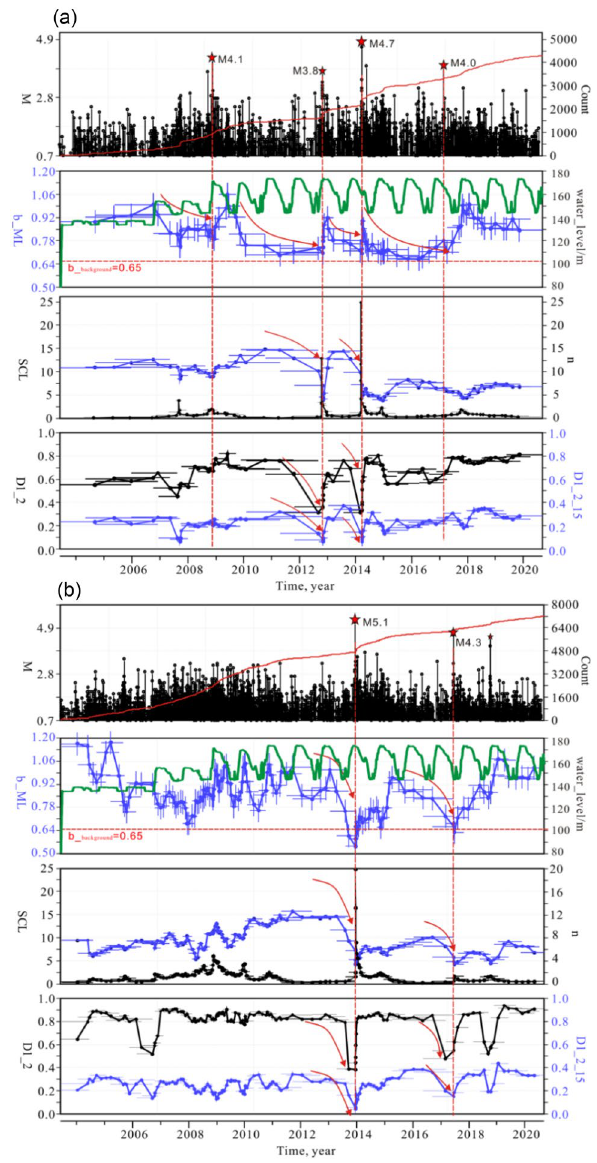
consecutive groups of 300 events with a running step of 50 events. Red vertical dashed lines show the positions of the M4.0 + earthquakes in Zigui and Badong area. The vertical blue bars in b _value show the standard error and the horizontal bars in b _value, D and SCL show the time scan window. Red horizontal line shows the background b -value in the Three Gorges reservoir. The red arrow lines indicate the trend of the statistical parameters. Green solid line shows the water level from May 2003 to May 2020 Red stars indicate the moderate earthquakes with M ≥